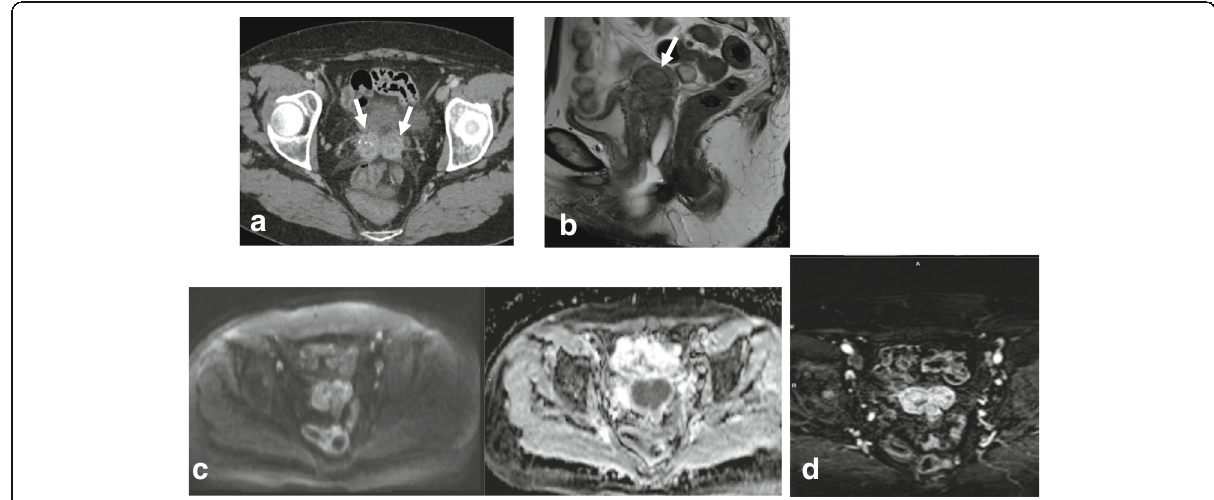
Fig. 23 Vaginal vault mass after surgery for cervical carcinoma (white arrows) visualized by sagittal T2WI ( a ), axial oblique T2WI ( b ), DWI ( b = 1000, ADC map) ( c ), and DCE ( d ). Imaging reveals diffusion restriction and early contrast uptake. Biopsy and histopathology